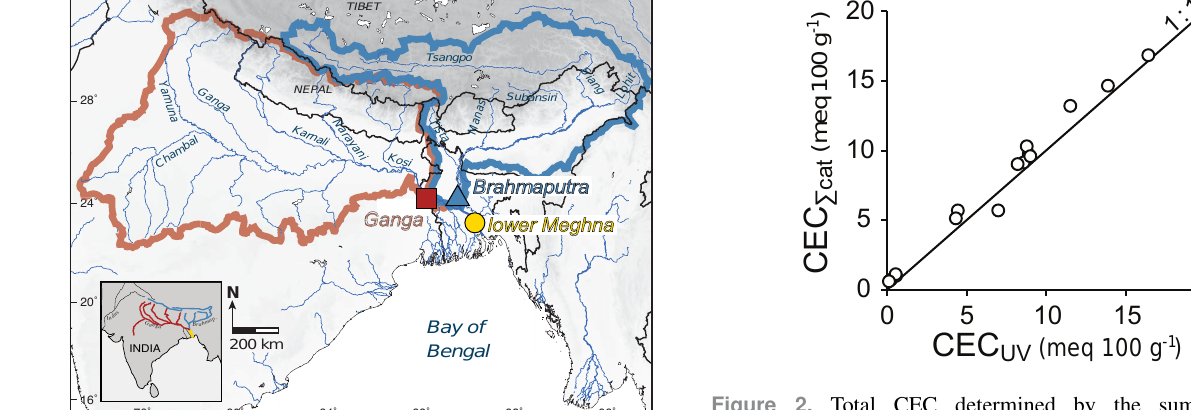
Figure 2. Total CEC determined by the sum of cations (Ca 2 + + Mg 2 + + Na + + K + ) released after sediment exchange with a CoHex solution (CEC (cid:54) ) as a function of the total CEC de- cat termined based on the absorption of cobalt ions from the CoHex solution after exchange (CEC UV ). For each sample CEC (cid:54) and cat CEC UV were determined on the same CoHex